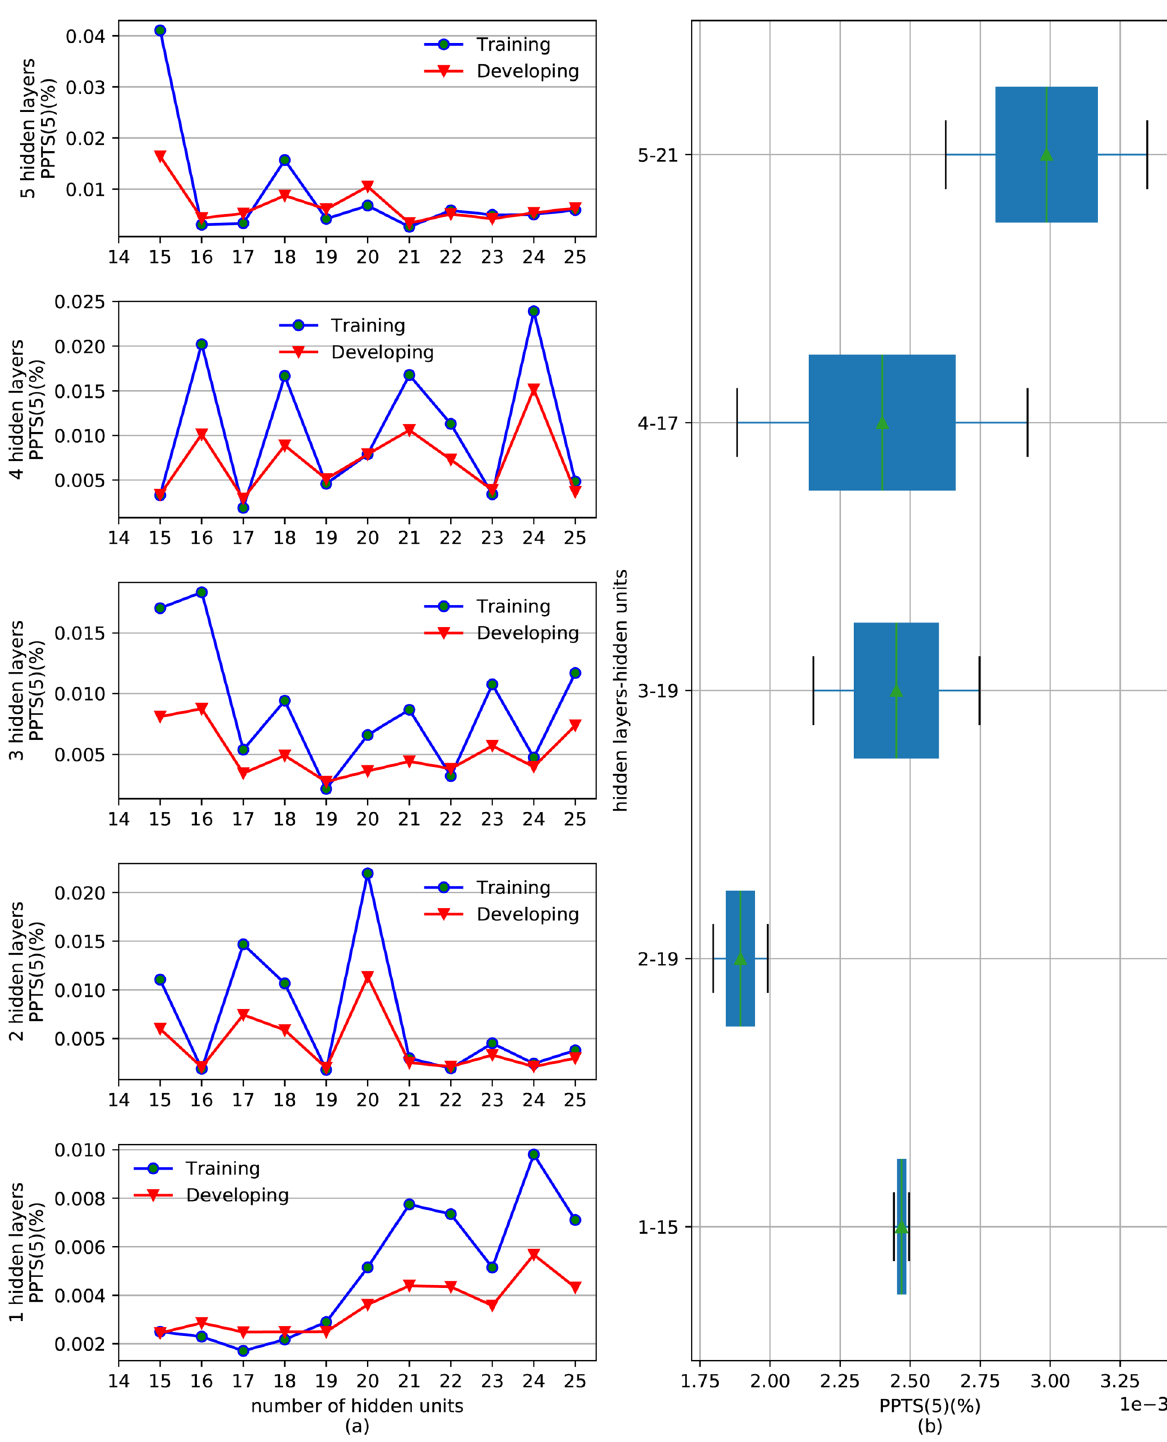
Figure 8. PPTS(5) of different LSTM structures for predicting streamflow of IMF 1 during the training and development period: ( a ) line chart plots of PPTS(5) for different hidden layers and ( b ) boxplots of the optimal structure of each hidden